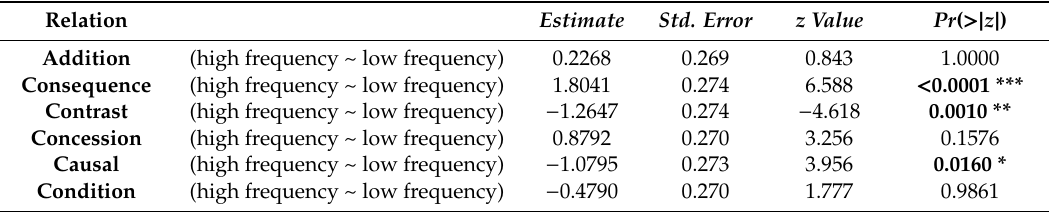
Table 8. Non-native speakers, di ff erences between the tested connectives within the relations.